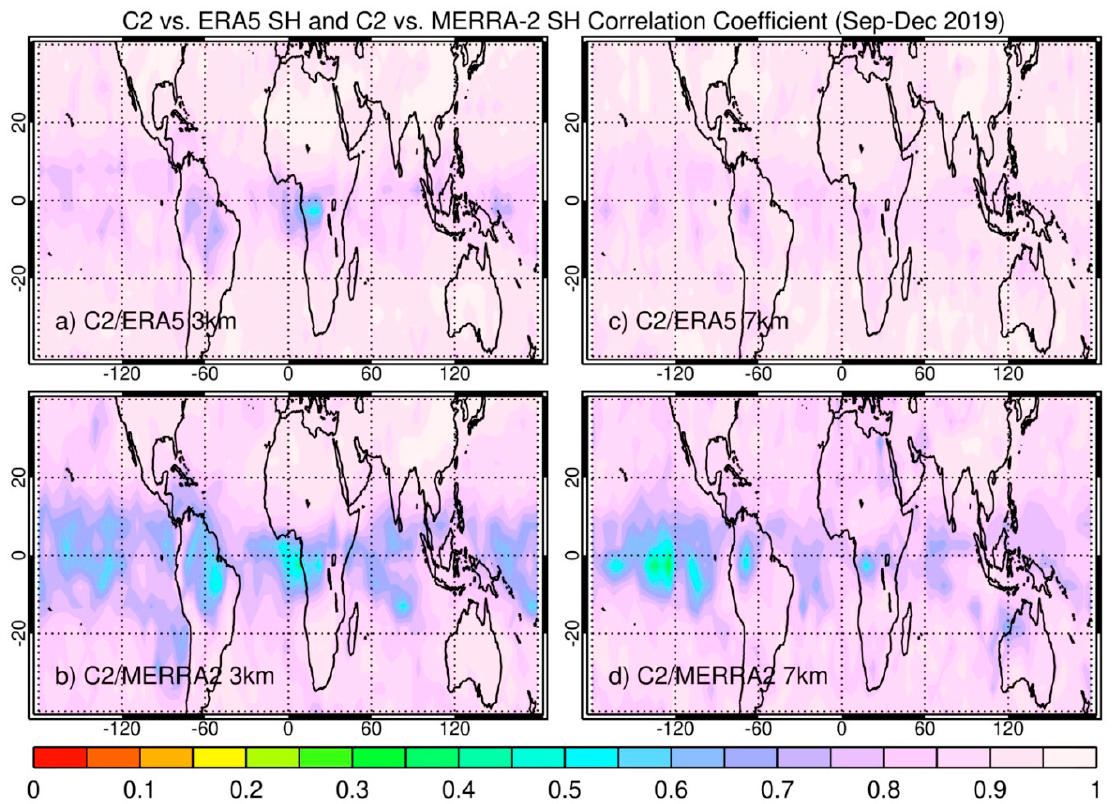
Figure 5. ( a , c ) Gridded correlation coefficients for C2 and ERA5 profile pairs at 3 km and 7 km, and ( b , d ) gridded correlation coefficients for C2 and MERRA-2 profile pairs at 3 km and 7 km within 40° N–40° S from September–December 2019.